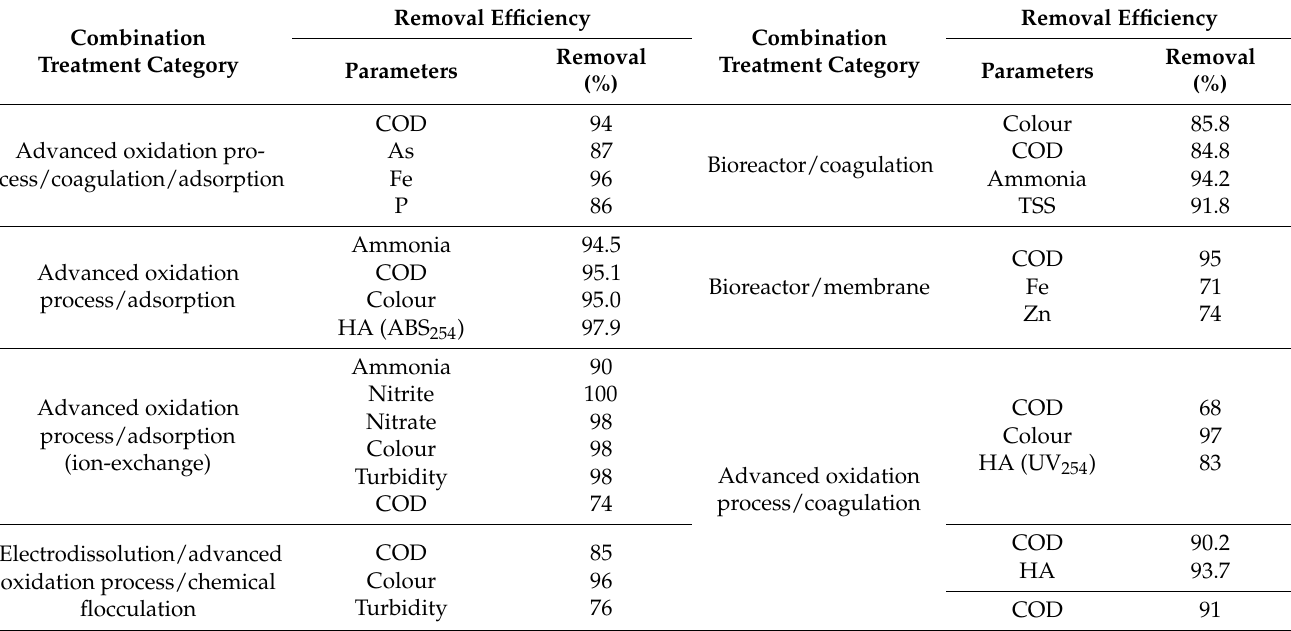
Table 7. Combinations of landfill leachate treatments from the